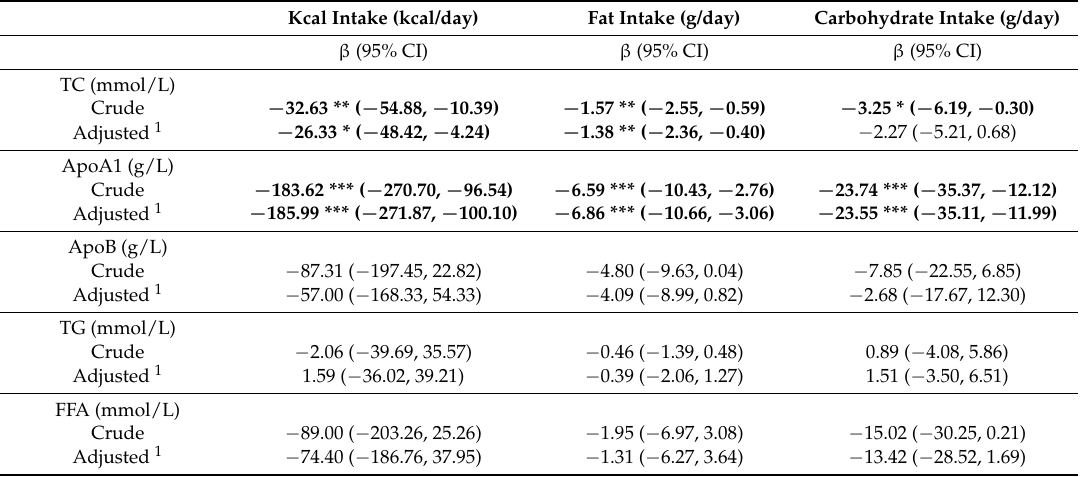
Table 5. Association between prenatal maternal lipid profile and offspring’s food intake at age